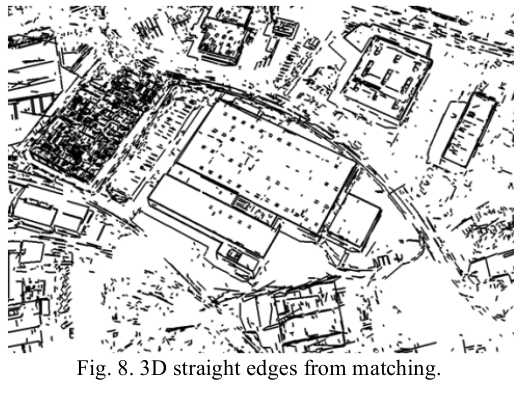
Fig. 8. 3D straight edges from